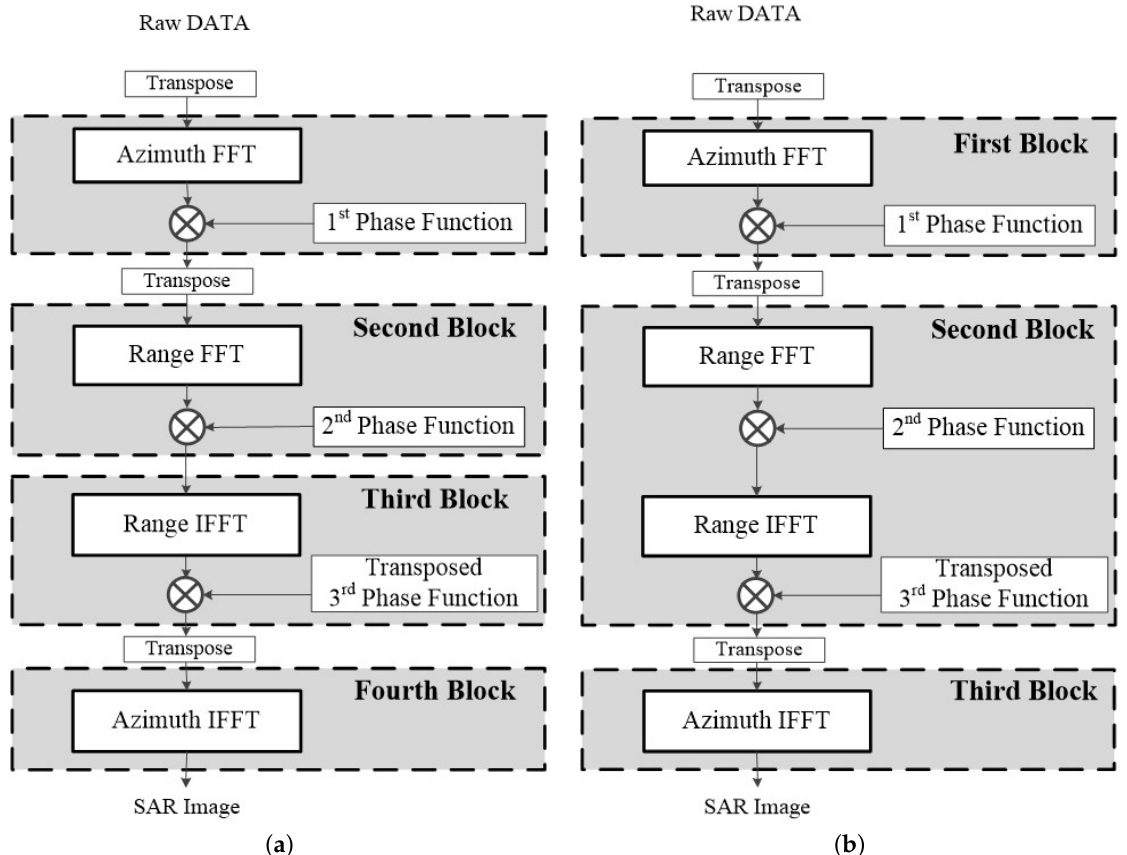
Figure 4. Modified CSA flows: ( a ) modified 1; ( b ) modified